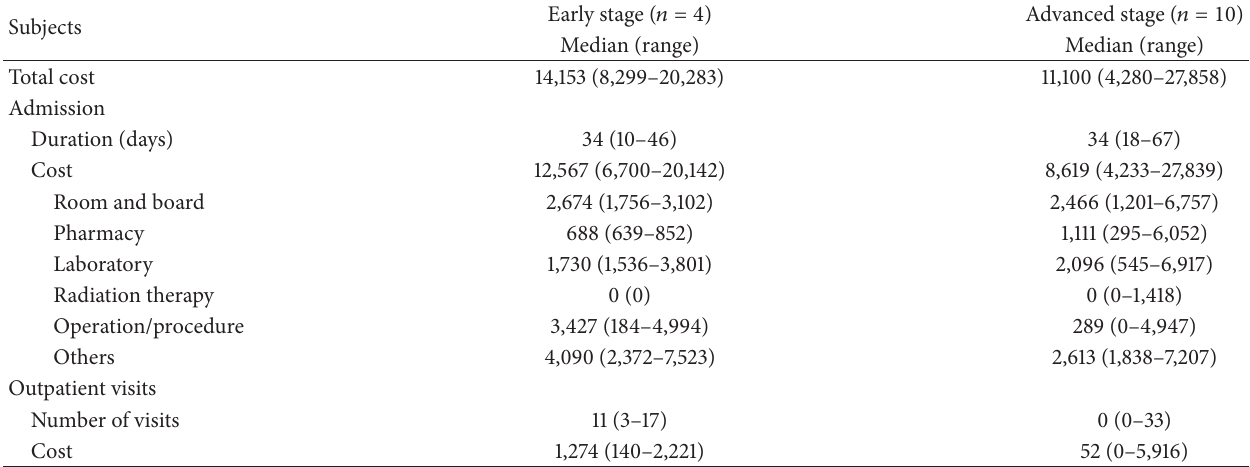
Table 3: Cost comparison between early stage and advanced stage disease ( 𝑛 = 14 ).